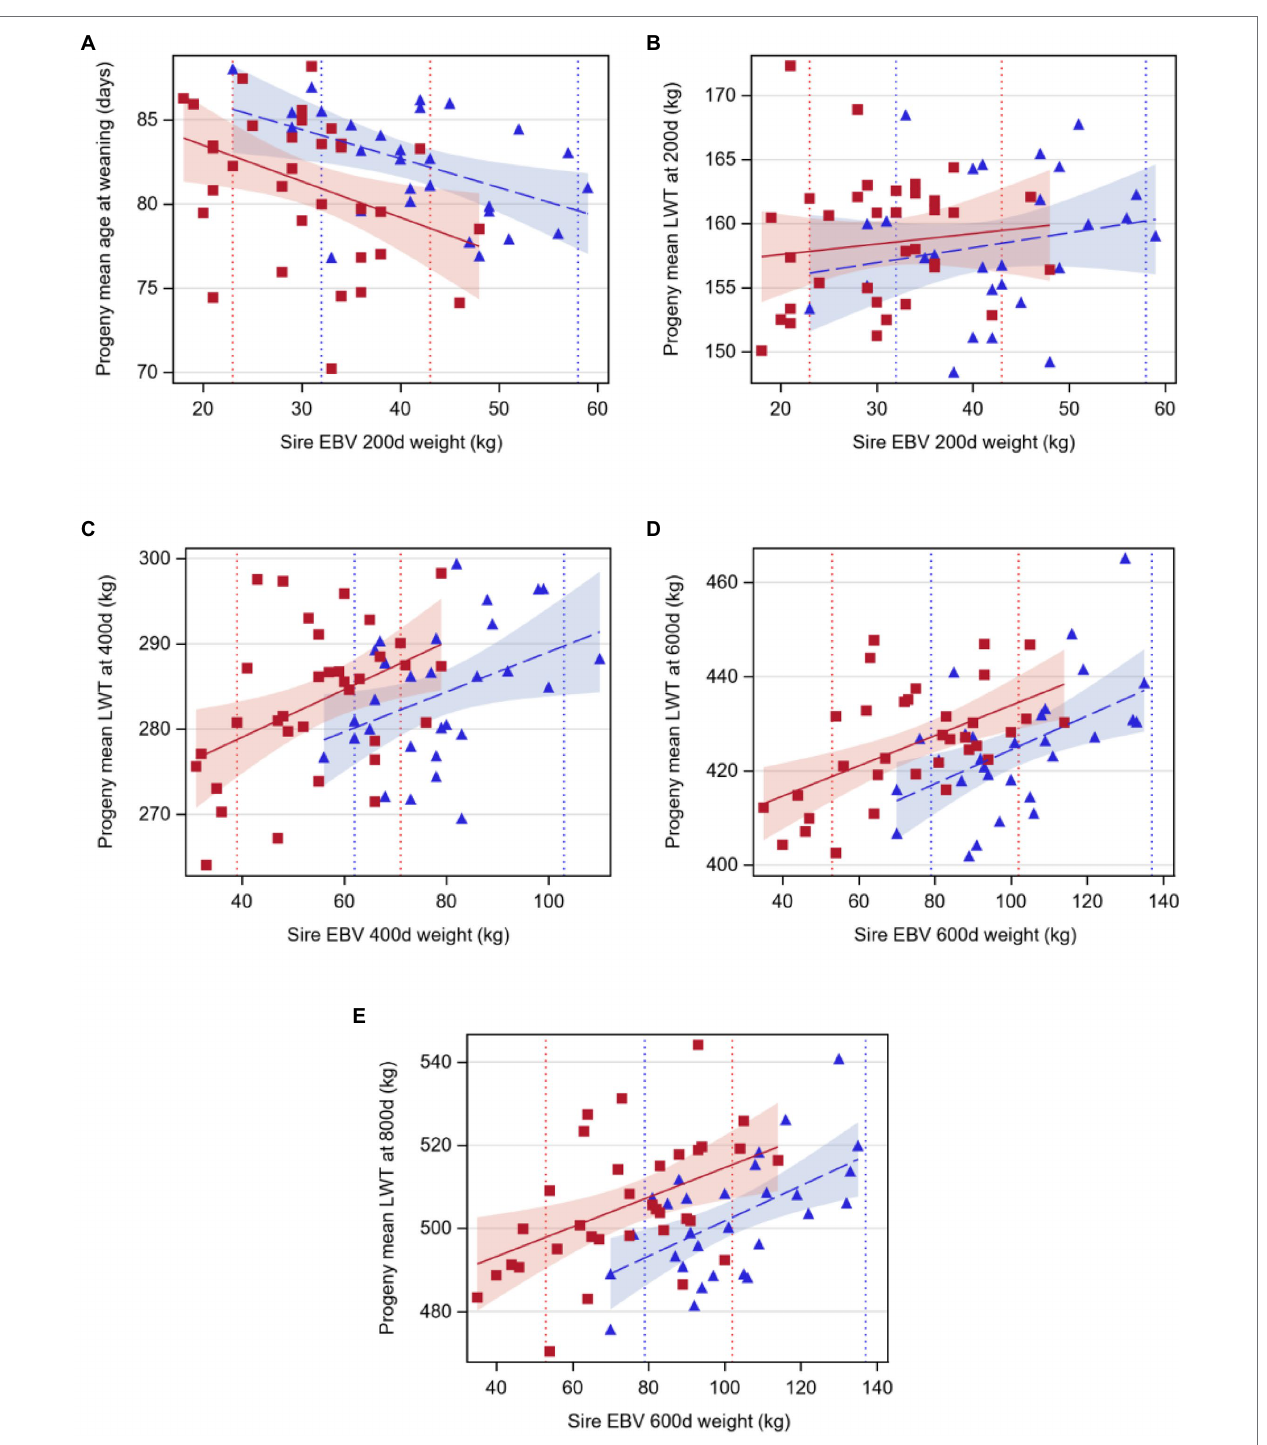
FIGURE 2 | Regression of least-squares means of beef-cross-dairy progeny groups on sire EBV for: (A) age at weaning (days) on weight at 200 days (kilograms), (B) liveweight at 200 days (LWT, kilograms), (C) liveweight at 400 days (LWT, kilograms), (D) liveweight at 600 days (LWT, kilograms), and (E) liveweight at 800 days on weight at 600 days (LWT, kilograms). Individual sires are represented by one data point (Angus, blue triangles, n = 29; Hereford, red squares, n = 34), and the regression lines by breed are indicated by lines (Angus, dashed line; Hereford, solid line). Shaded areas indicate 95% confidence intervals for the expected regression line for each breed (Angus, blue; Hereford, red). Colored dotted lines indicate 5 and 95th EBV percentiles for 2018 born calves within the BREEDPLAN population for each breed (Angus, blue; Hereford, red). Details of regression coefficients are presented in Table 4